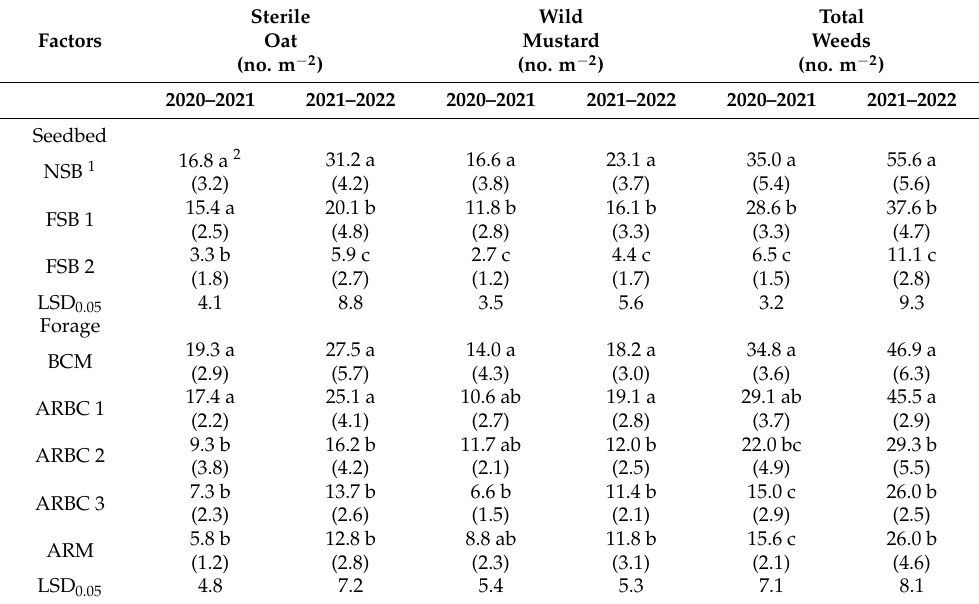
Table 3. Sterile oat density (no. m − 2 ), wild mustard density (no. m − 2 ), and total weed density (no. m − 2 ) in 2020–2021 and 2021–2022 (“no.” is the abbreviation of “number”). Sterile Factors Oat (no. m − 2 )